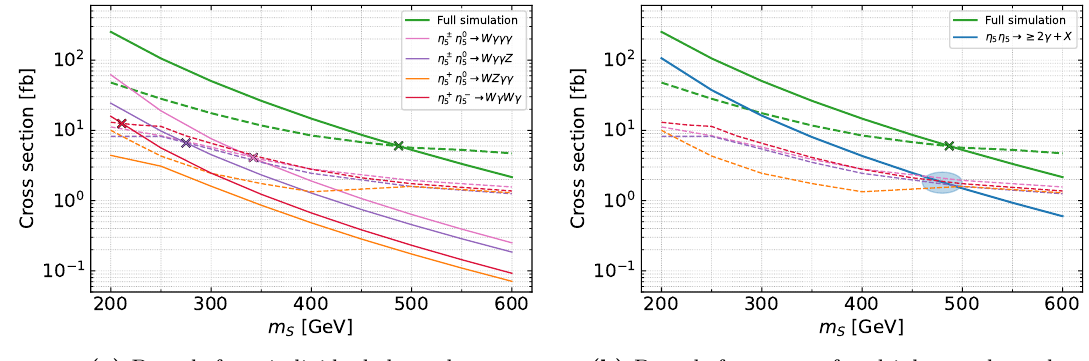
Figure 7. Application of the model-independent bounds to a specific model, the custodial quintu- plet η from the SU (5) / SO (5) coset. In (a) we determine the bounds from the dominant individual 5 channels by comparing the cross section time branching ratio from the model (solid) with the upper limits from figure 2 (dashed). In green we show the results of a full simulation. The blue line in (b) is the sum of the individual multi-photon cross sections shown in (a). Further details are given in the